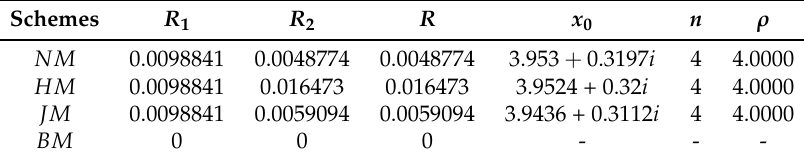
Table 2. Comparison on the basis of different radius of convergence for Example 2.